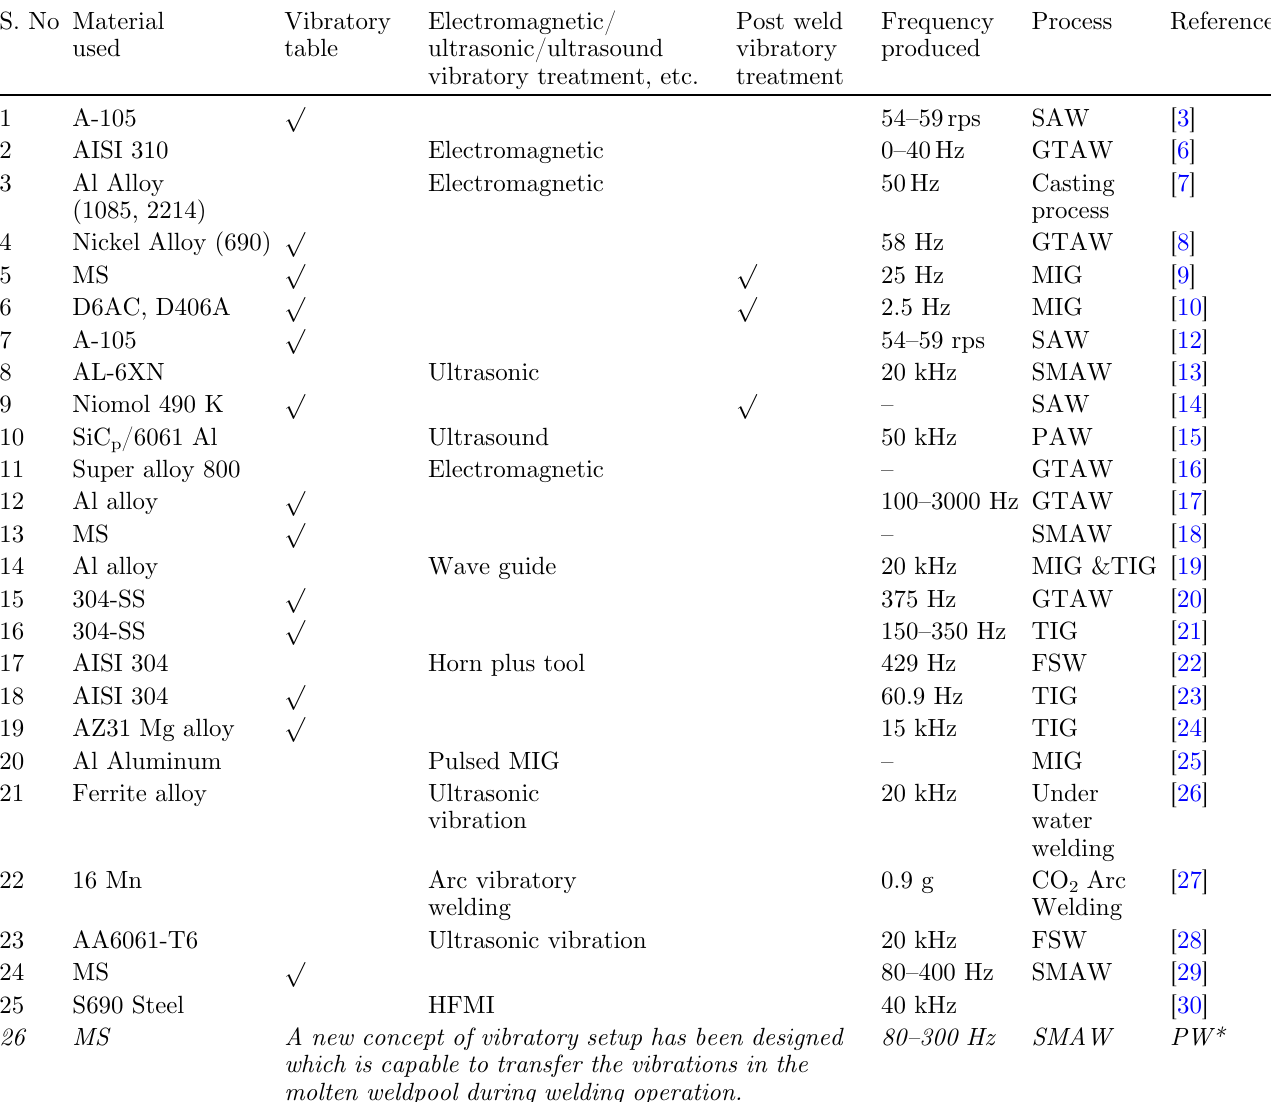
Table 1. A comparative study between various vibratory welding techniques and the experimental setup used in the present work.